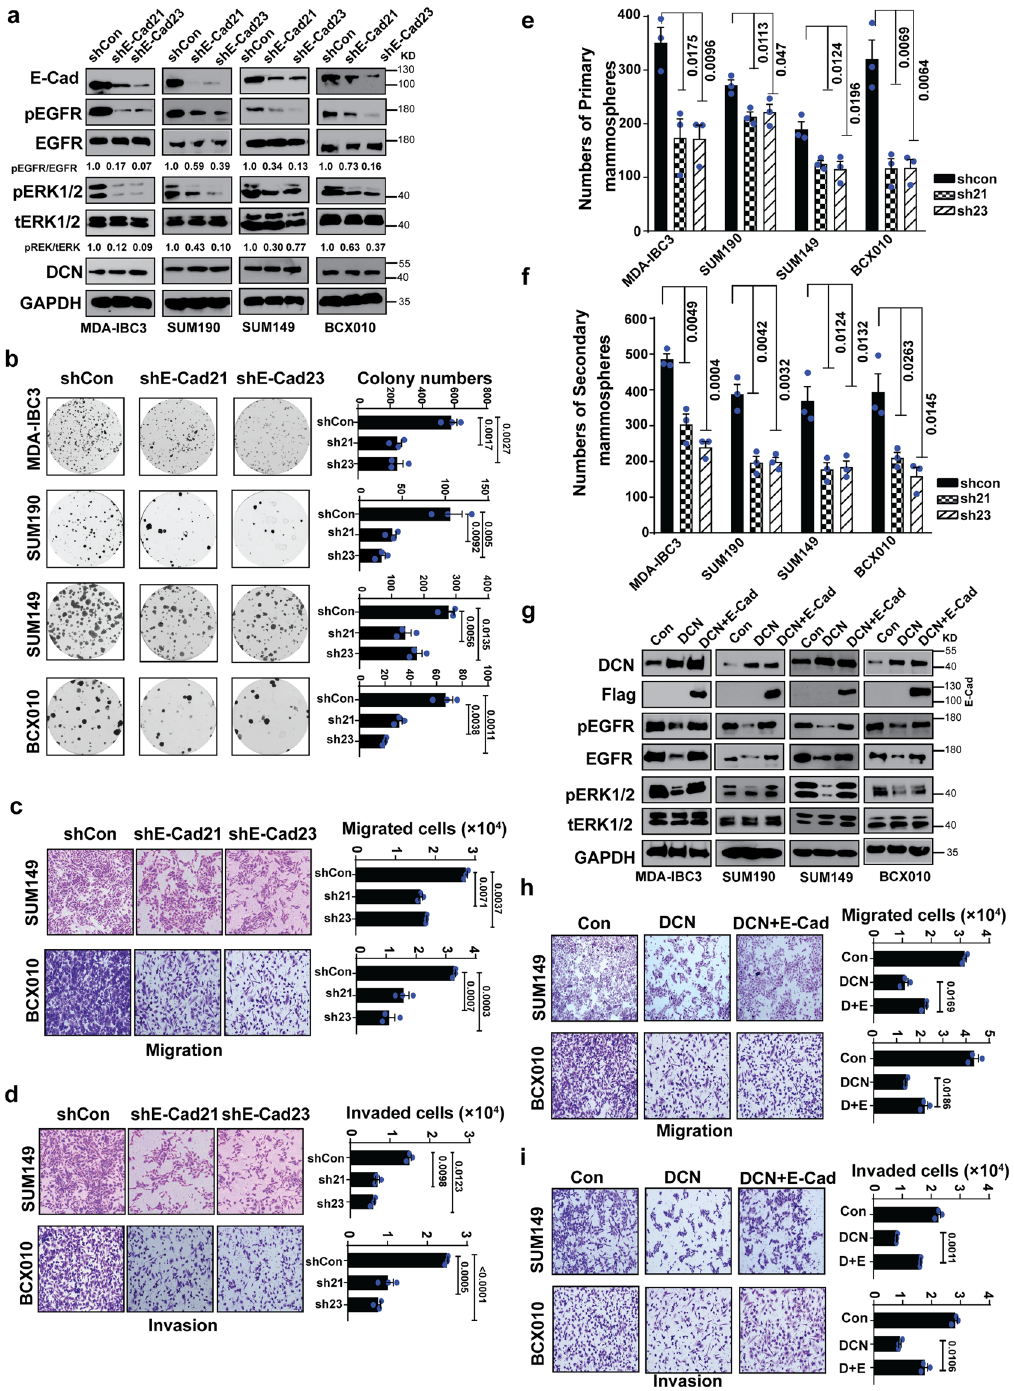
Fig. 4 DCN suppresses aggressiveness in IBC by regulating the E-cadherin – EGFR axis. a E-cadherin knockdown in IBC cells results in the inhibition of EGFR signaling but does not affect DCN expression. E-cadherin knockdown in IBC cells lines was achieved by transduction with two independent lentiviral shRNAs. Total cell lysates were analyzed by western blotting for EGFR pathway analysis. GAPDH served as a loading control. b – f E-cadherin knockdown in IBC cell lines suppresses colony formation ( b ), migration ( c ), invasion ( d ), primary mammosphere formation ( e ), and secondary mammosphere formation ( f ). g Restoring E-cadherin rescues EGFR signaling in DCN-overexpressing IBC cells. Flag-E-cadherin plasmid was transfected into DCN-overexpressing IBC cell lines for 48 h and cell lysates were subjected to western blotting. h and i Restoring E-cadherin increases migration ( h ) and invasion ( i ) in DCN- overexpressing SUM149 and BCX010 IBC cell lines. P values are from Student ’ s unpaired t tests. Data are shown as mean ± s.e.m. Data shown are representative of three independent experiments.